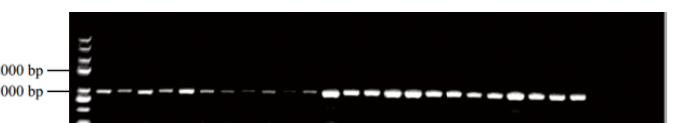
Figure 5. Schematic of T-DNA region of the expression vector construct. Abbreviations: 35S, cauliflower mosaic virus 35S promoter; SP, signal peptide of tobacco-patheogenesis-related 1a protein; His6: histidine tag; KDEL: endoplasmic reticulum retention signal; NPTII: sequence of neomycin phosphotransferase gene.